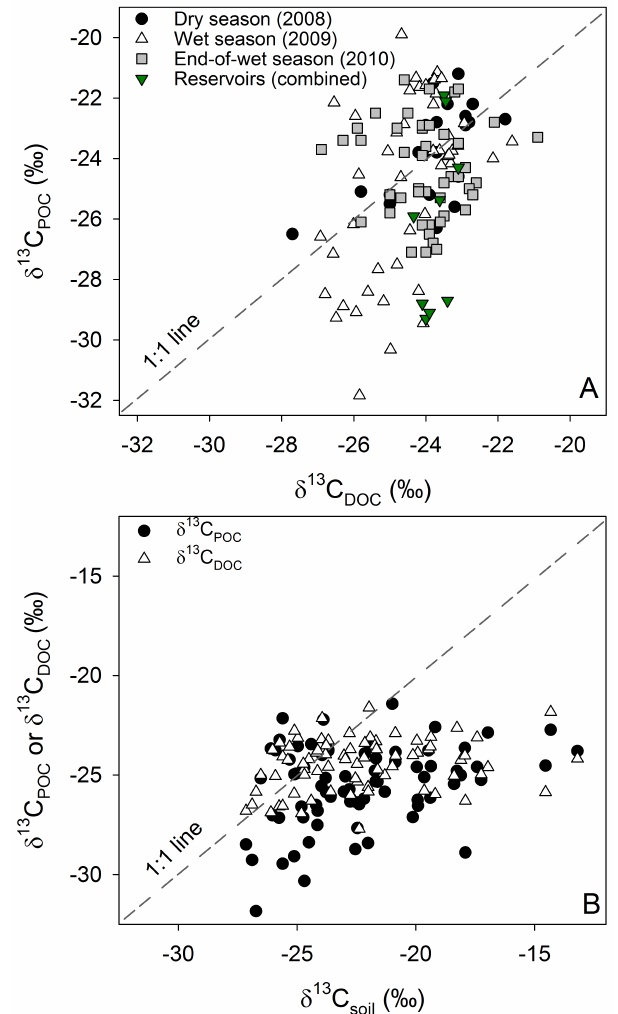
Fig. 8. Plots of (A) sediment core depth vs. sediment %OC (B) sediment core depth vs. δ 13 C sediment at Masinga